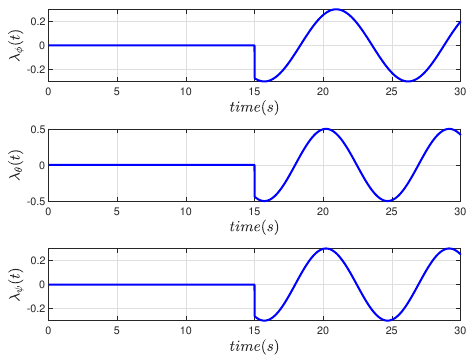
Figure 2. Actuator Anomalies for Position Channel.